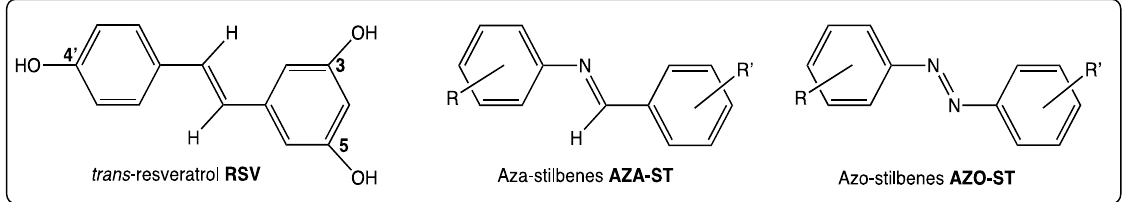
Figure 1. Structure of trans ‐ resveratrol RSV , aza ‐ stilbenes AZA ‐ ST and azo ‐ stilbenes AZO ‐ ST.